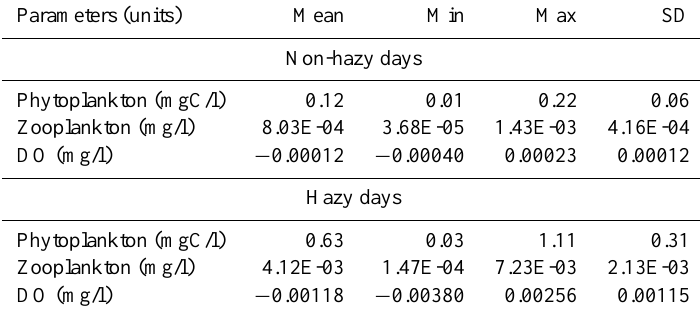
Table 5. The percentage increase of model computed concentration of phytoplankton, zooplankton and dissolved oxygen (DO) at surface water from baseline during non-hazy and hazy